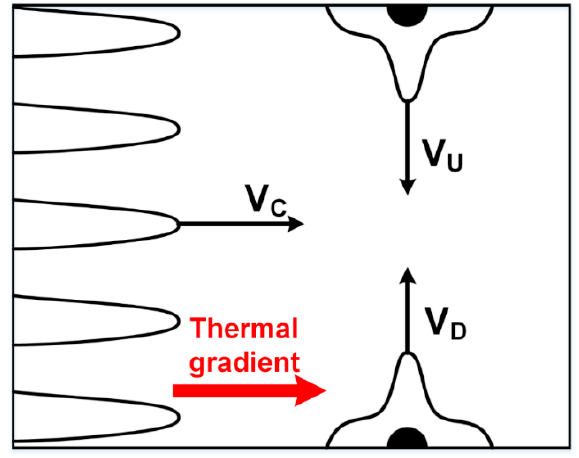
Figure 12. The growth of columnar and equiaxed grains.